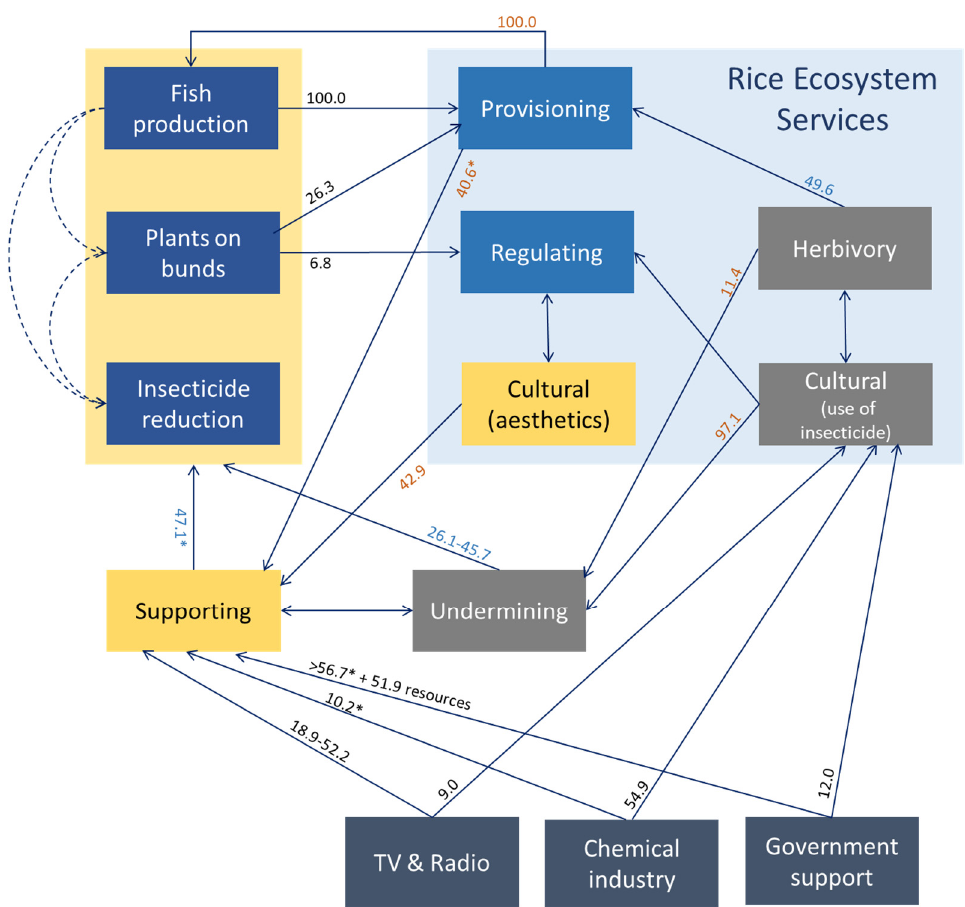
Figure 5. Summary of incentives and disincentives for farmers to adopt ecological engineering in rice ecosystems based on surveys from south Vietnam. Provisioning, regulating and cultural services are indicated with regulating disservices (herbivory) and cultural disservices (belief that insects reduce yields and insecticides are necessary) associated with the rice ecosystem. Restoring services from human society to the rice ecosystem are indicated as plants on bunds, insecticide reduction and rice–fish systems. The underlying supporting services and disservices (undermining) are linked to the restoration services. Services are indicated by blue rectangles and disservices by grey rectangles (see also Figure 2). The main external influencers are indicated by dark blue rectangles, such as ‘TV & Radio’, ‘Chemical industry’ and ‘Government Support’. Numbers in black indicate percentages of farmers mentioning the associated linkages (indicated by arrows) (Table 1). Numbers in brown indicate farmers’ motivations for choosing specific plants based on Table S2 as well as their satisfaction or dissatisfaction with planted bunds or insecticides. Numbers in blue indicate farmers’ expressed satisfaction or dissatisfaction with ecological engineering based on Table S4. Numbers with asterisks are significantly different between conventional and ecological engineering farmers (including former-EE